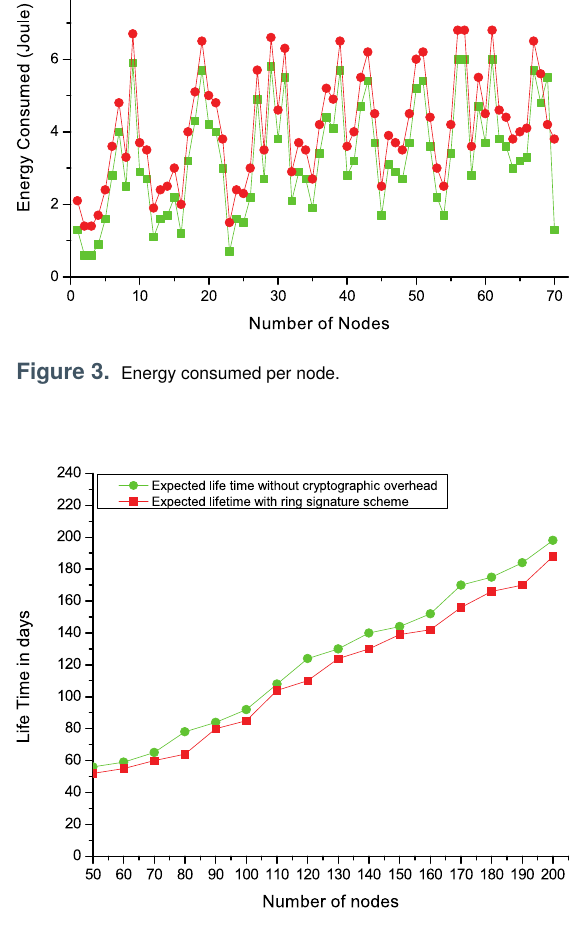
for 70 nodes deployed in meter area with ring size 3 for simulation of 7200 s. From the figures, we observe that the maximum throughput of a node is 160 kbps and minimum is found to be 10